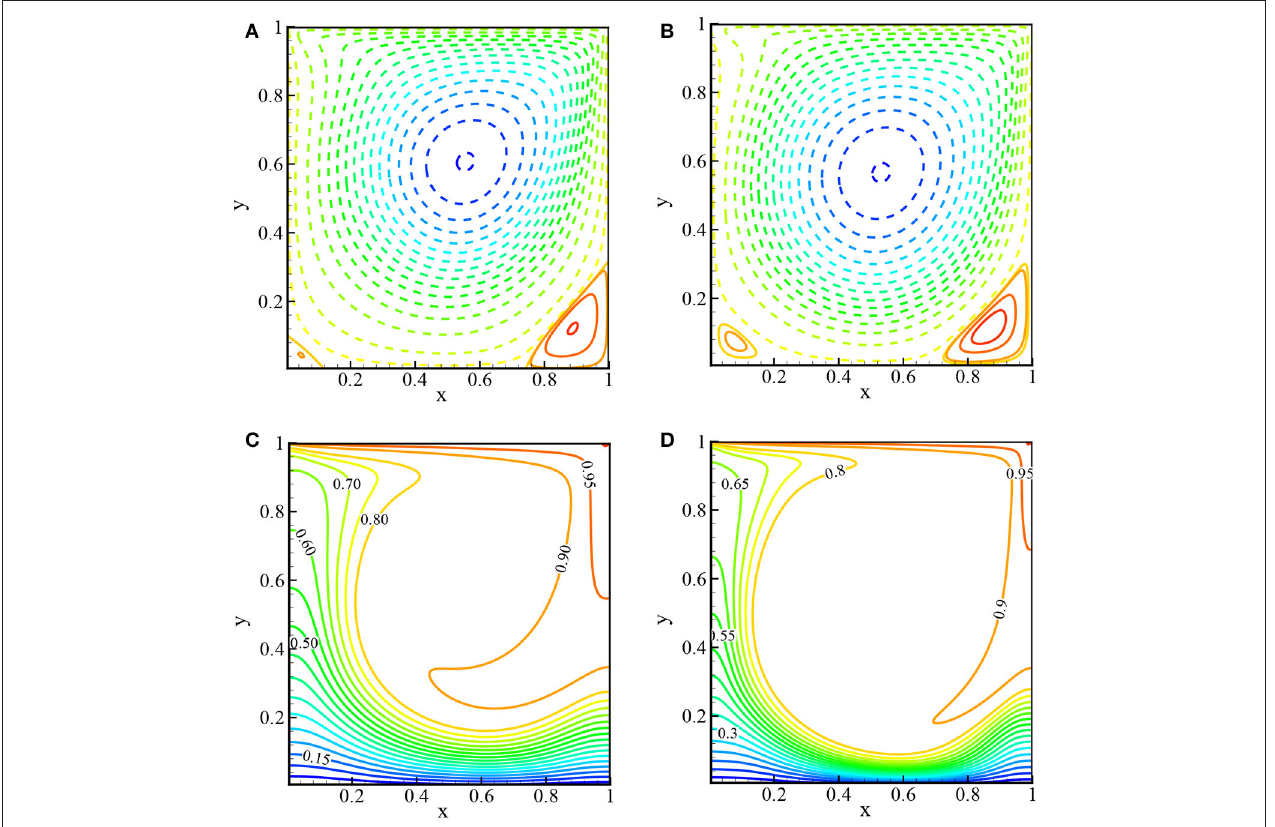
FIGURE 13 | Streamlines (top): (A) Re